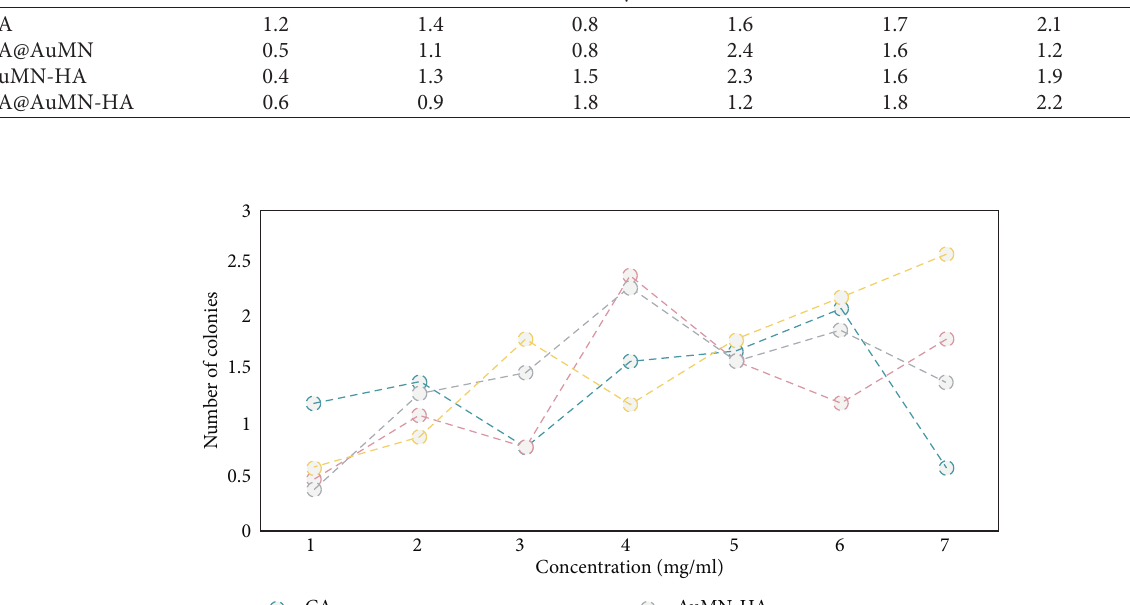
Table 3: Plate colony count results.